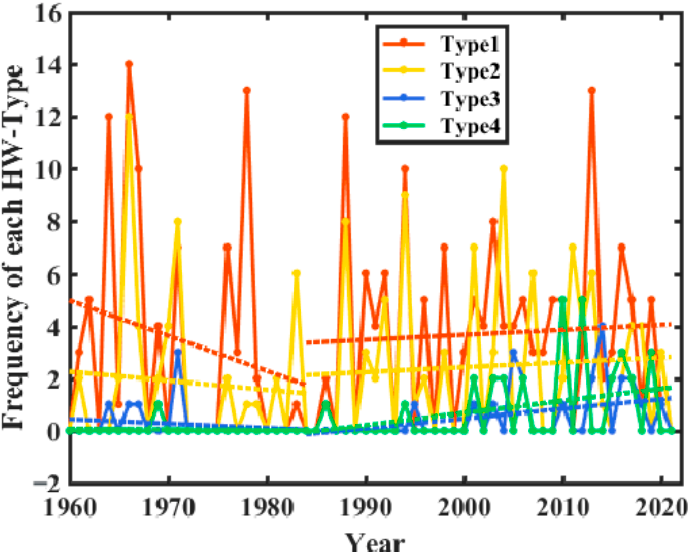
Figure 5. Changes in heat wave (HW) day frequency corresponding to each of the four synoptic weather types.